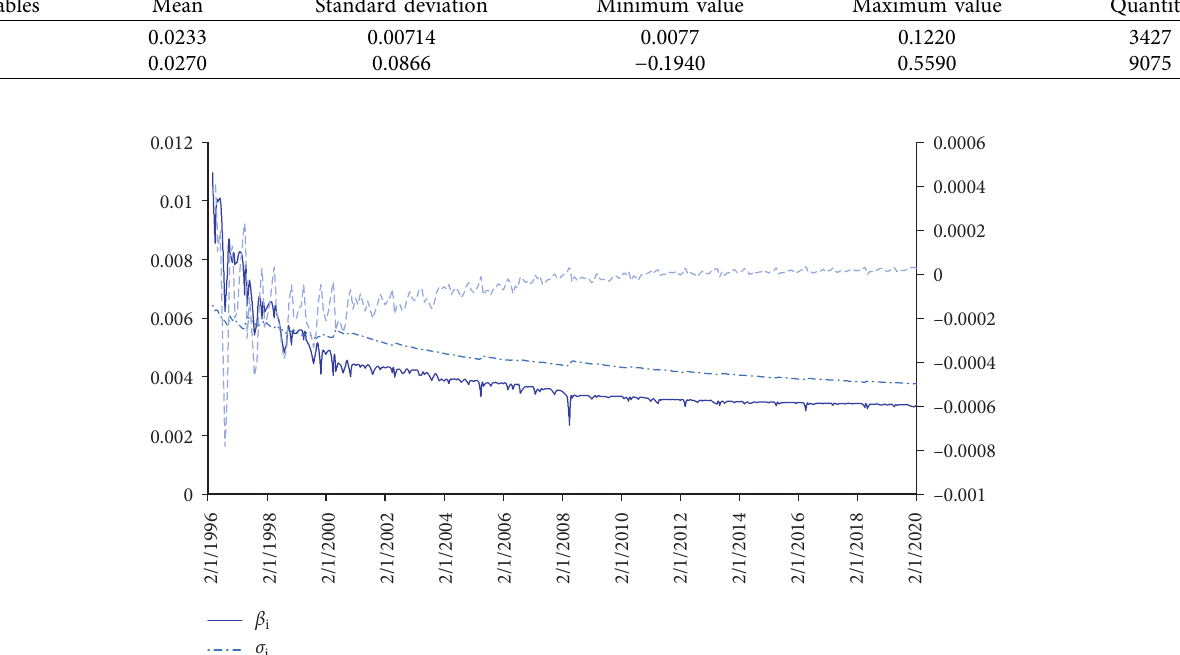
i is the right-side secondary axis, and